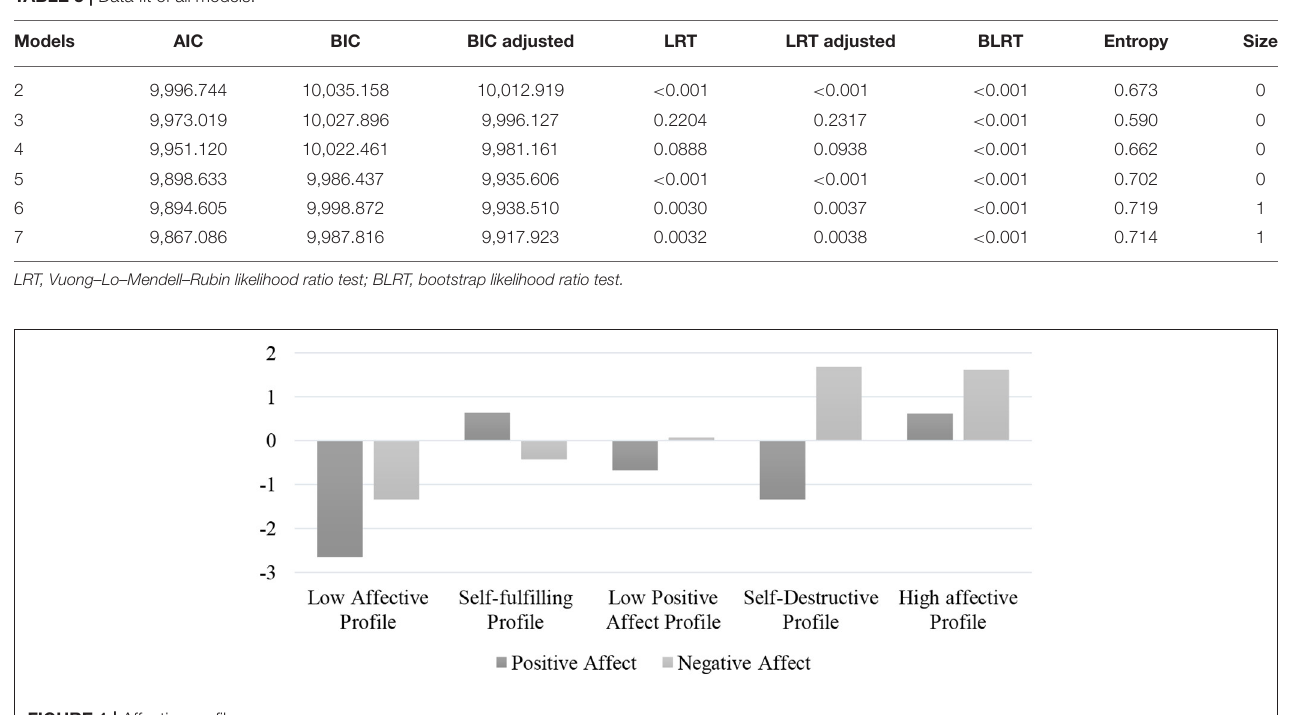
TABLE 3 | Data fit of all models.